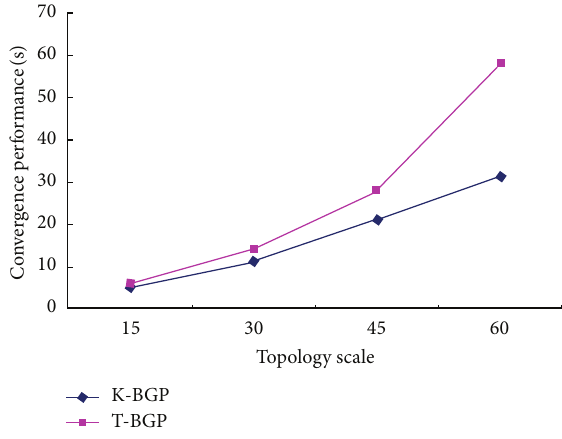
Figure 8: Convergence performance comparison based on differ- ence topology